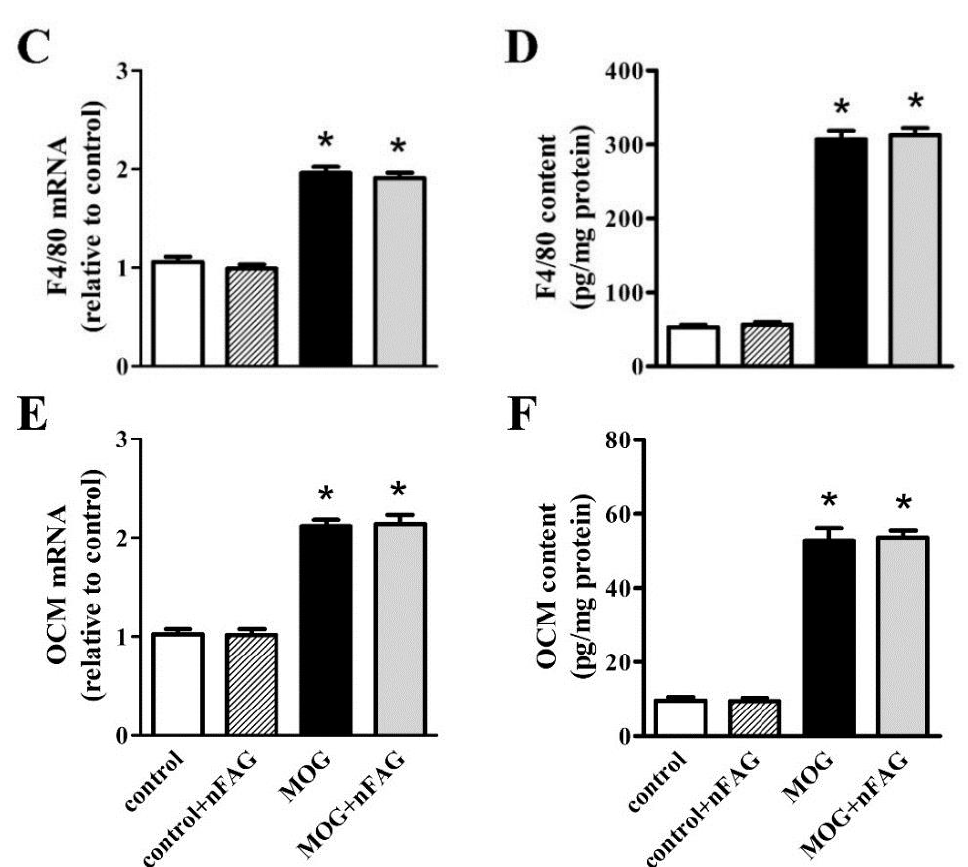
Figure 4. nFAG dietary supplementation does not affect MOG-induced upregulation of markers of macrophage infiltration including cluster of differentiation 68 (CD68; A , B ) and endothelial growth factor-like module-containing mucin-like hormone receptor-like 1 (F4/80; C , D ), as well as the expression and the content of oncomodulin (OCM; E , F ). Levels were evaluated in control and MOG-treated mice, without or with nFAG dietary supplementation. Transcripts ( A , C , E ) were evaluated by relative quantification with qPCR. Data were analyzed by the formula 2 − ∆∆ CT using Rpl13a as the internal standard. Proteins ( B , D , F ) were evaluated by ELISA (LifeSpan Biosciences, Inc., Seattle, WA, USA). Data are shown as the mean ± S.E.M. ( n = 9 for each experimental group). * p < 0.001 versus control (one-way ANOVA followed by the Newman-Keuls multiple comparison post-hoc test). White bars, control mice; dashed bars, control mice with nFAG dietary supplementation; black bars, MOG-treated mice; grey bars, MOG-treated mice with nFAG dietary supplementation.